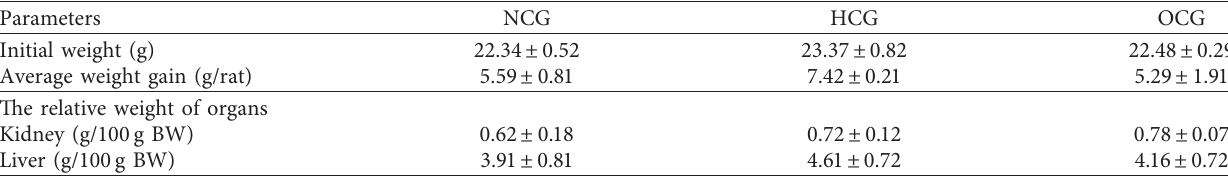
Table 2: Effect of the ODSO on growth